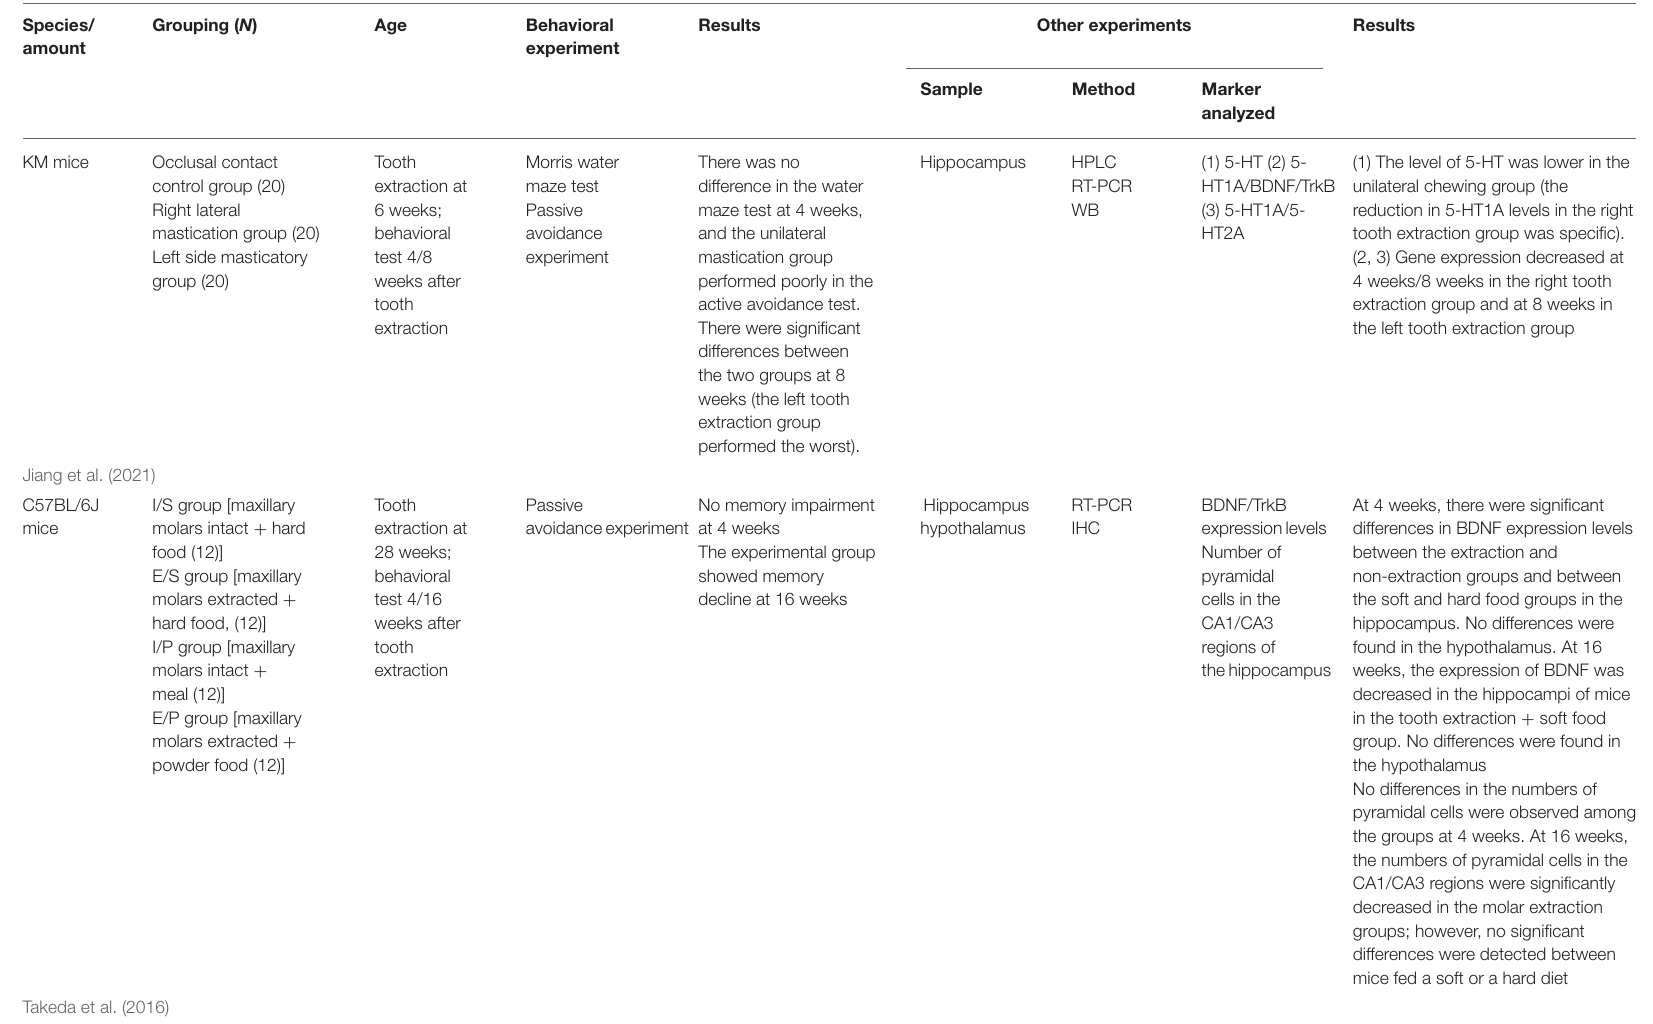
TABLE 3 | The mechanical pathway. Species/